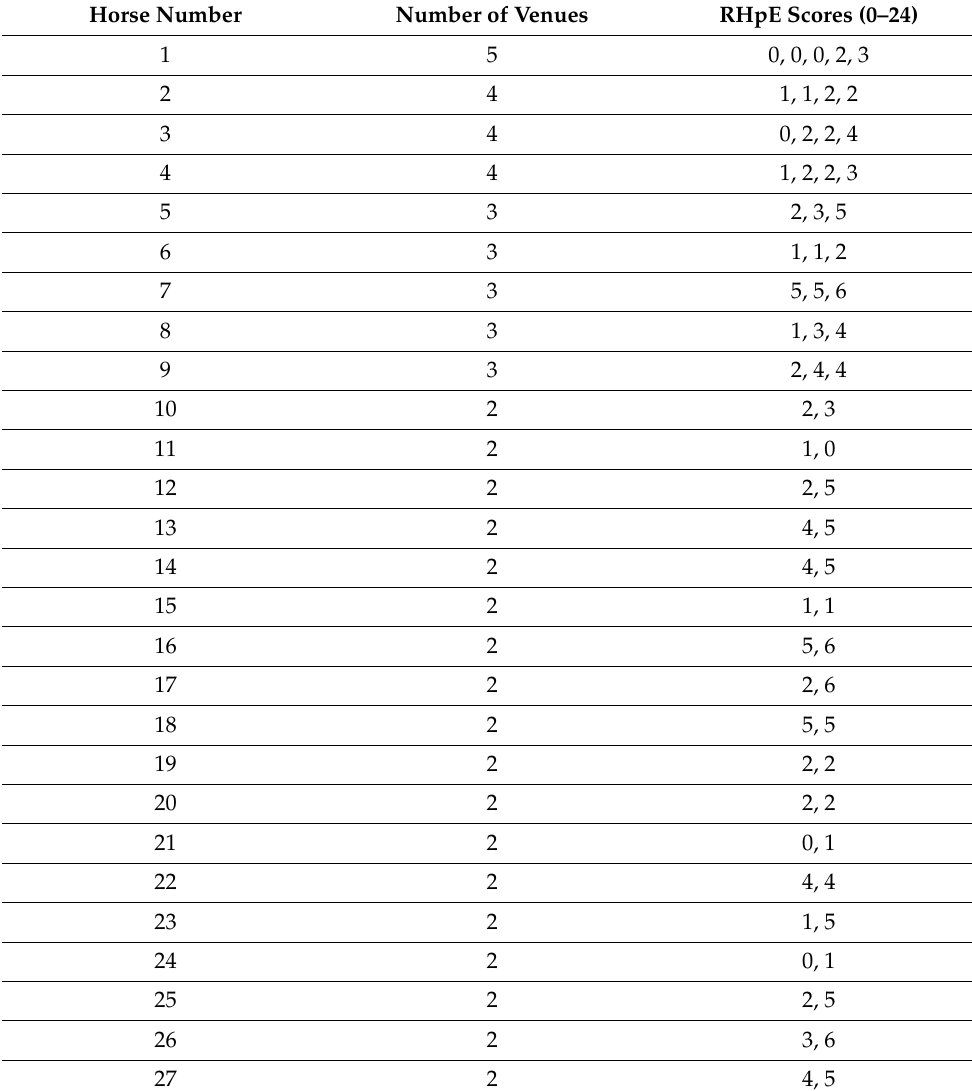
Table 5. Summary of the total Ridden Horse Pain Ethogram scores for 27 horses which competed at more than one World Cup Grand Prix Dressage Western League qualifying competition ( n = 7) or final ( n =